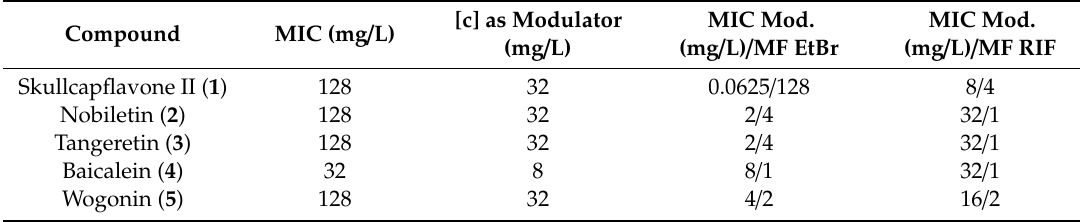
Table 2. Determination of the MICs and modulation factors of the compounds for M. smegmatis mc 2 155 by using microbroth dilution